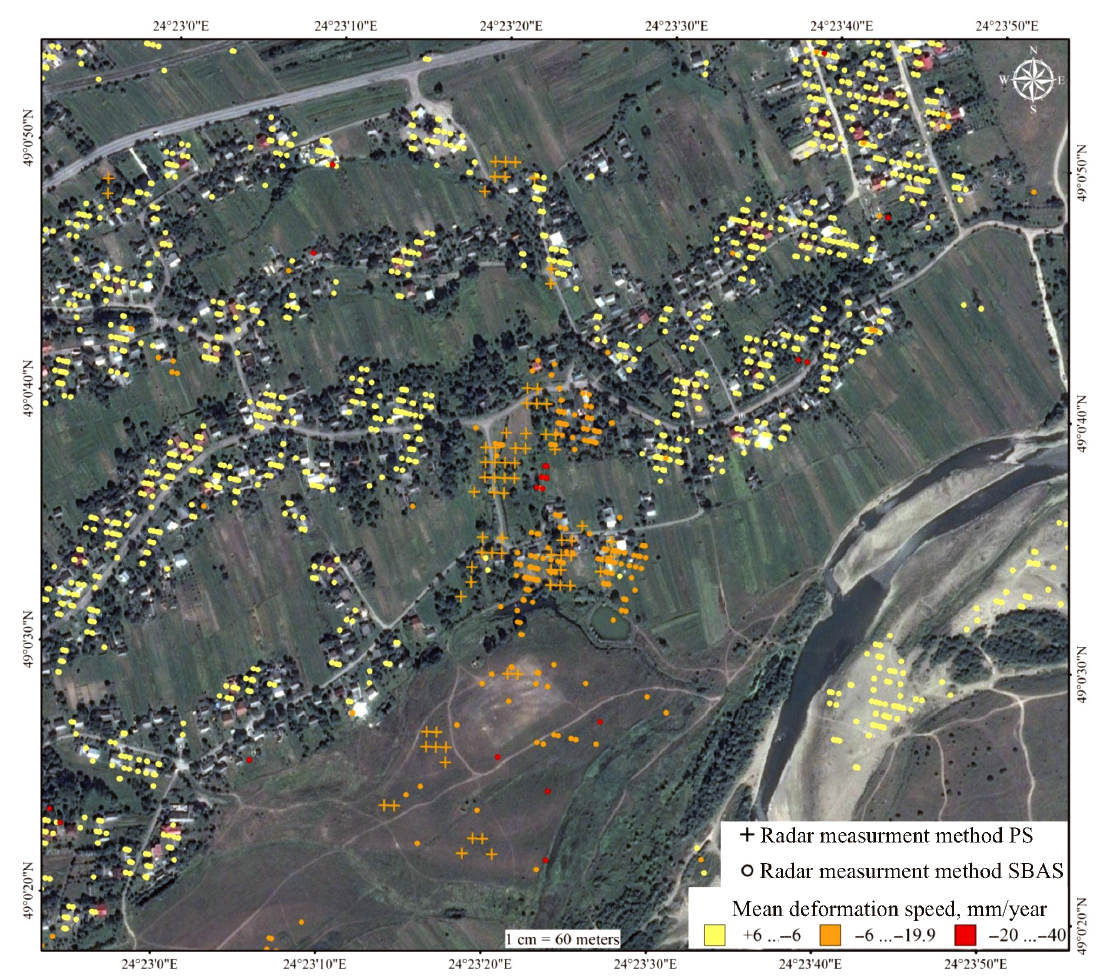
Figure 2. Layout of permanent stable reflectors of the radar